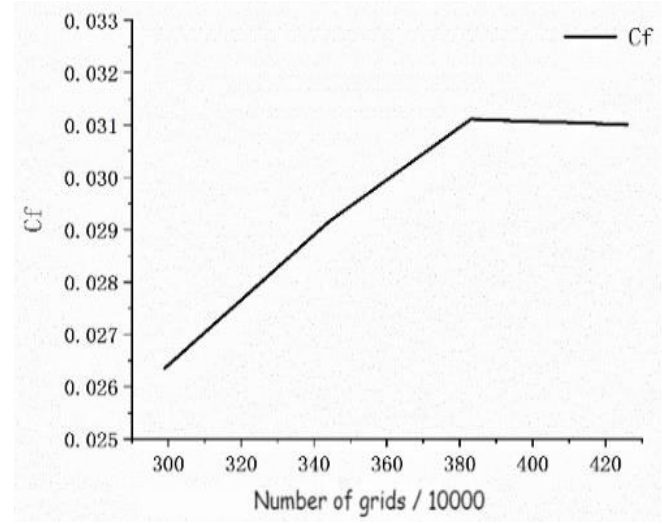
Figure 8. Friction drag coefficient of smooth plate under different mesh numbers.